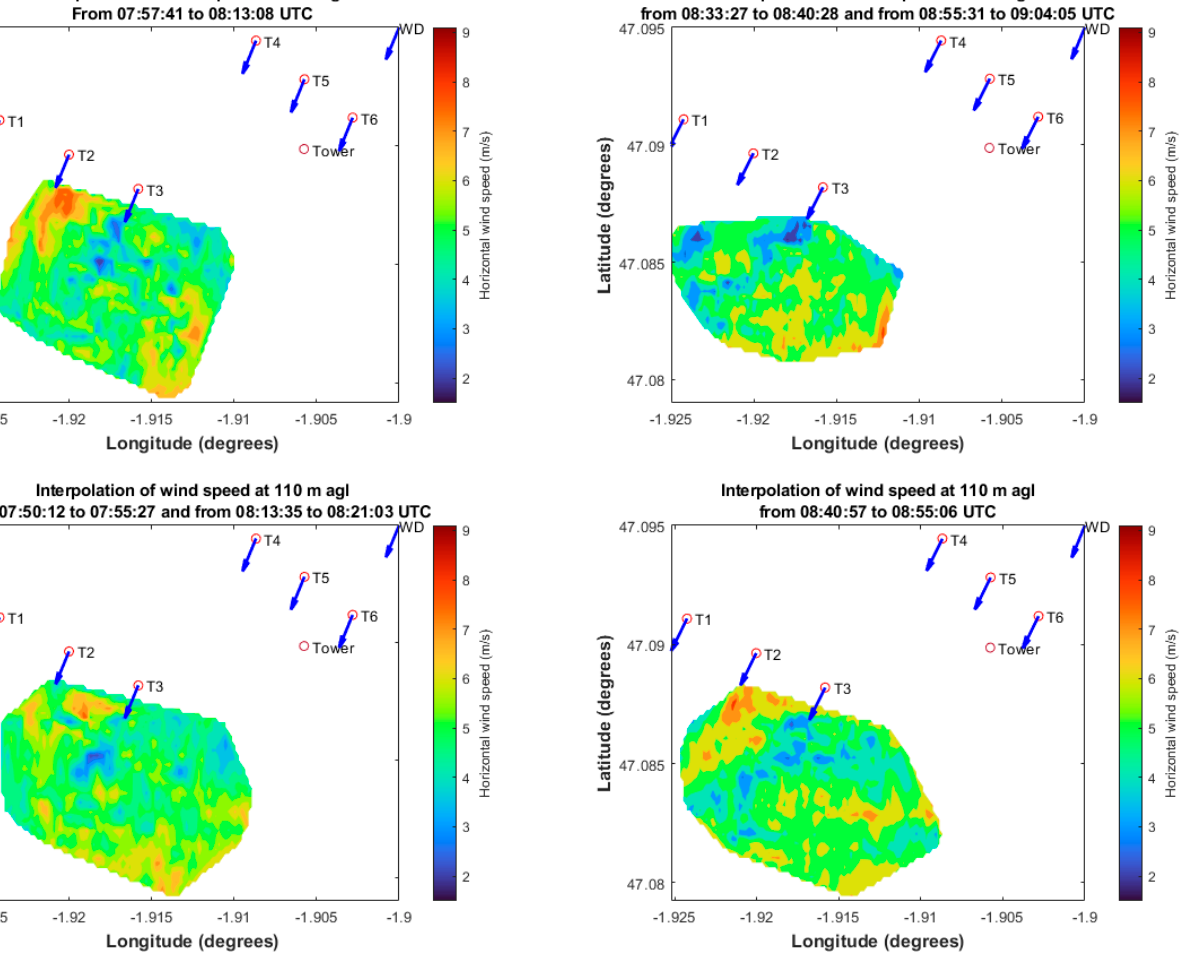
Figure 8. 2-D fields of horizontal wind speed measured on 30 April at distinct moments at 90 m ( top ) or 110 m agl ( bottom ). The blue arrows represent the direction of the wind averaged over the interpolated field during the corresponding sequence. T1 to T6 are the localizations of the six wind turbines.